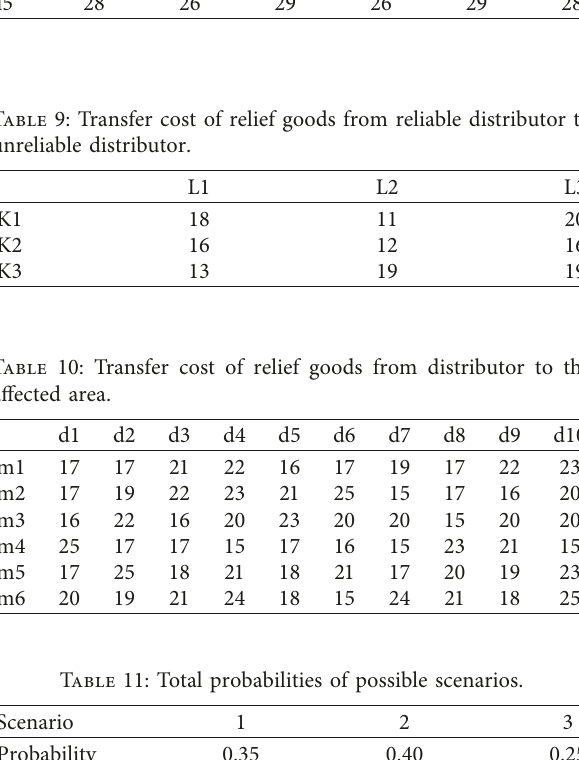
Table 3: Fixed cost of building central warehouse j.